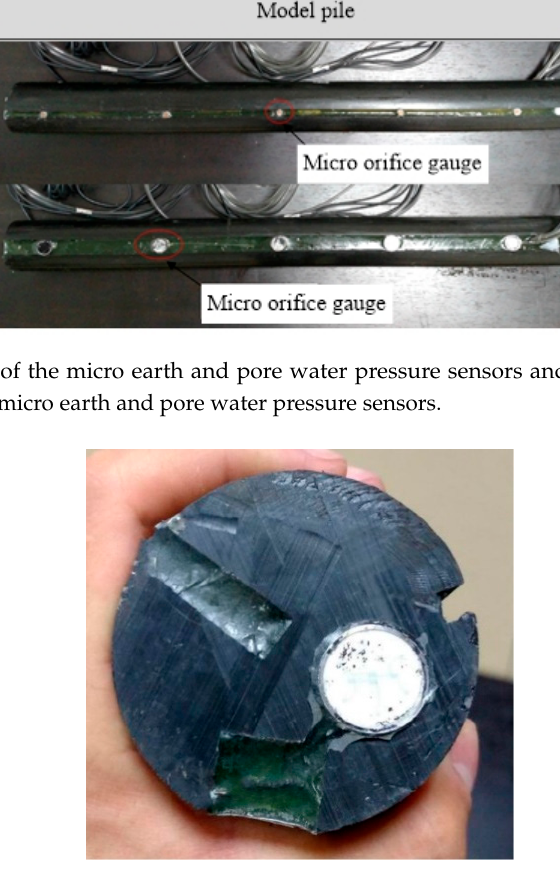
Table 1. Physical and mechanical parameters of the tested soil.